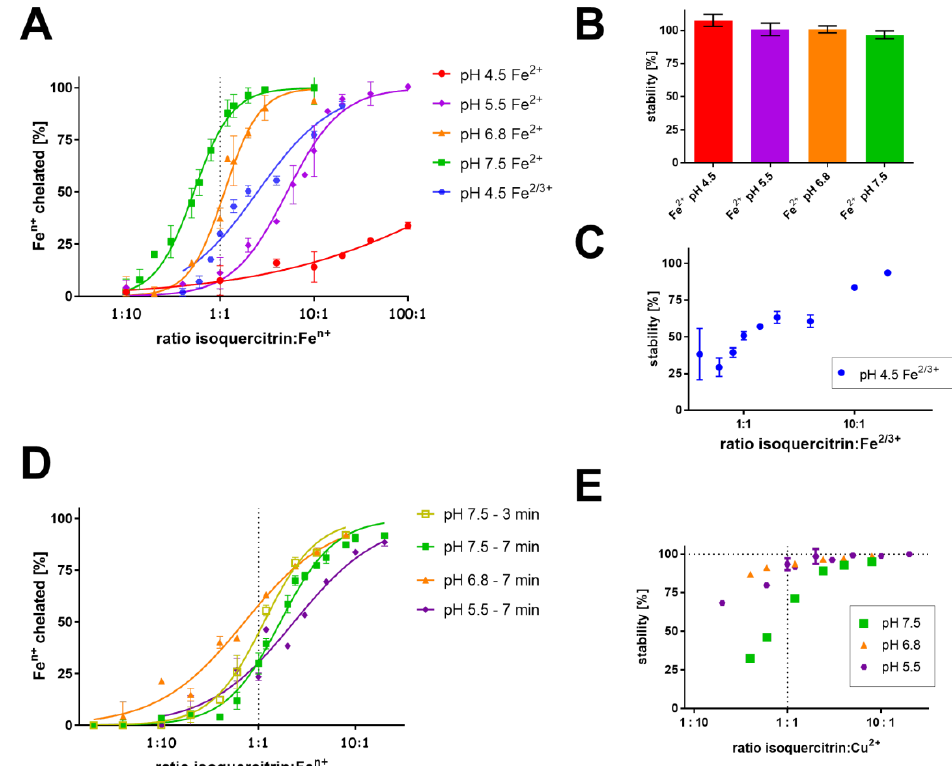
Figure 3. Competitive assessment of iron and copper chelation. Iron chelation by isoquercitrin (ferrozine method) is shown in section ( A ) with the stability of formed complexes in parts ( B ) and ( C ). Cupric chelation by isoquercitrin (haematoxylin method) is depicted in section ( D ); ( E ) describes the corresponding stability of these cupric complexes. Isoquercitrin was mixed with the respective metal ions in different buffers for 2 min, the indicator (ferrozine or haematoxylin) was added and the absorbance was measured immediately and then after 5 min (iron) or 7 min (copper, see the Experimental ection 2.4). The chelation results means the percentage of metal chelation calculated vs. blank sample containing the metal ions without isoquercitrin (data on iron are after 5 min, data on copper are specified in the legend). Stability was calculated as the change of percentage of metal chelation after 5/7 min vs . the first immediate measurement. Cupric chelation at pH 4.5 cannot be established due to low affinity of the indicator for copper at this